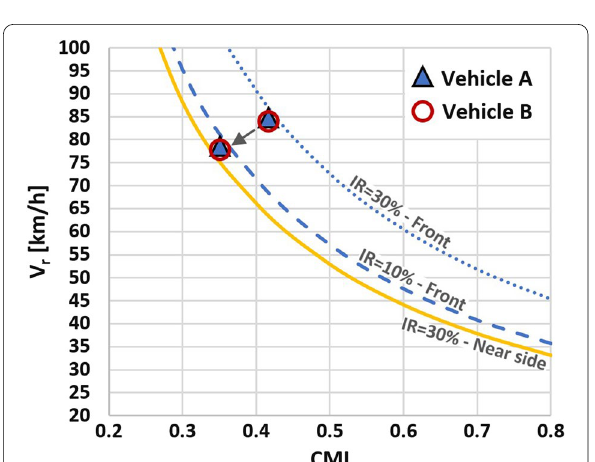
Fig. 6 Changes of position on the CMI- V r plane for the two vehicles, moving from the RS to the MS because of activation of the AEB on board vehicle A